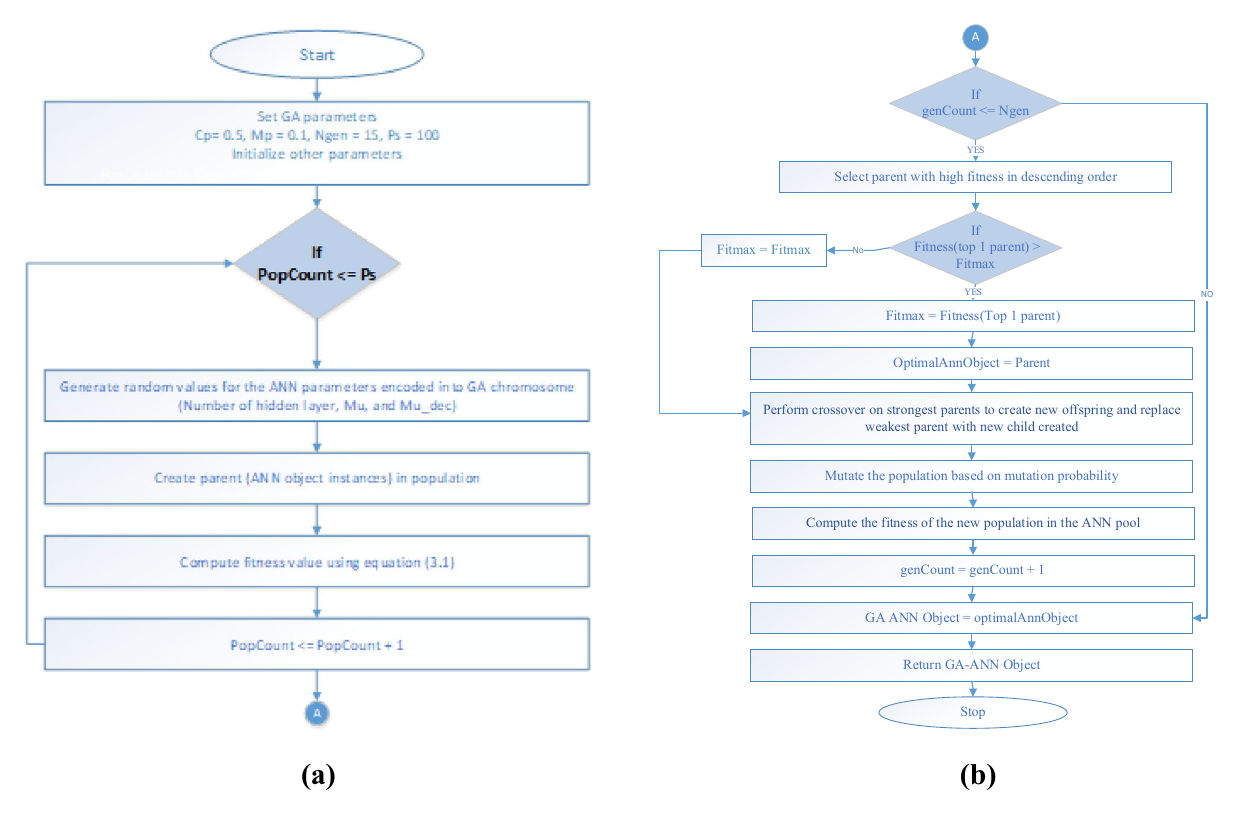
Figure 10. ( a ) First stage flowchart of the GA-ANN training phase. ( b ) Second stage flowchart of the GA-ANN training